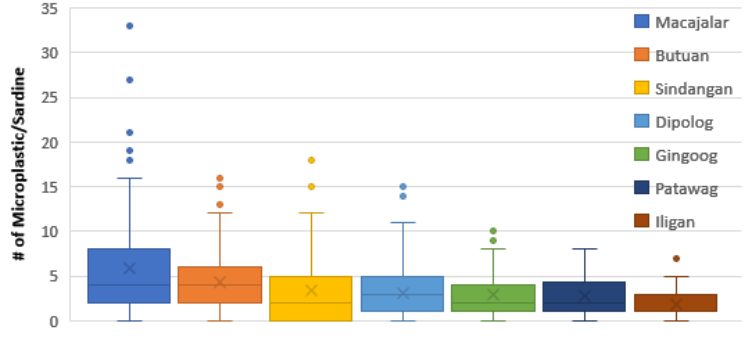
Fig. 7: Summary of ingested microplastics in sardines from the different bays across Northern Mindanao from 2014 to 2016. Data are the sample means (x), median (-), minimum & maximum (whiskers), 25 th – 75 th percentile (box), and outliers (dots).